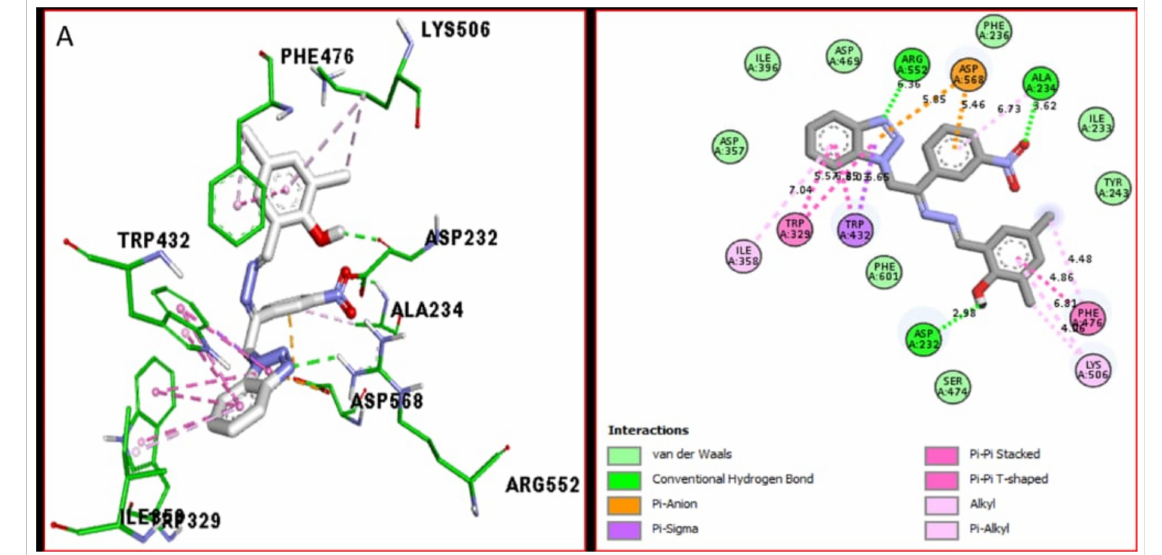
Figure 6. The protein-ligand interaction (PLI) profile of the most potent compound 9 against α - glucosidase ( A ) for compound 9 against the α -glucosidase enzyme.